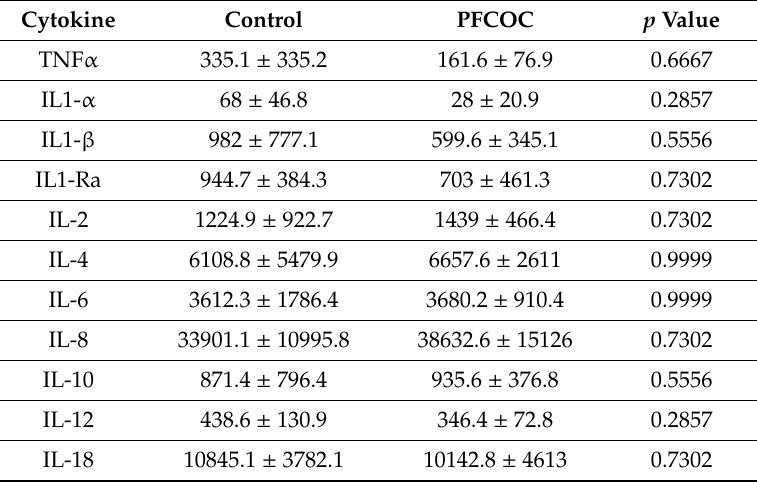
Table 1. Perfusate cytokine levels at the end of 6 h